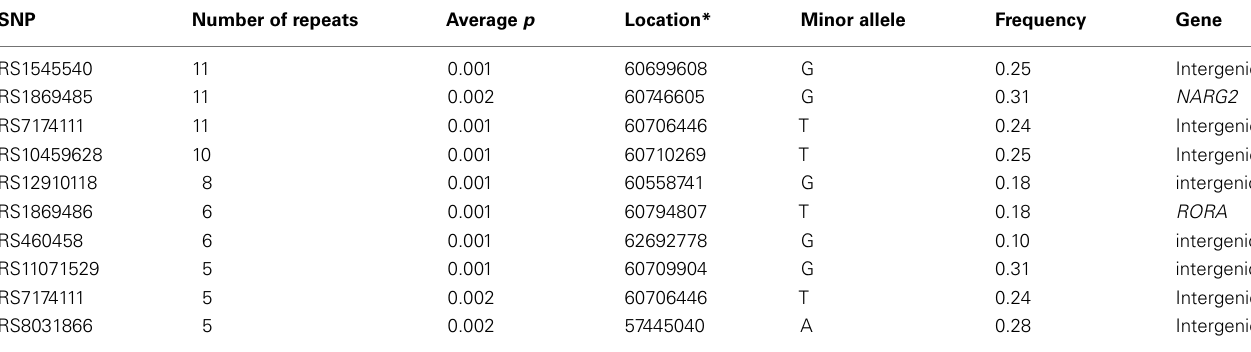
*Location is reported based on the 37.1p map.